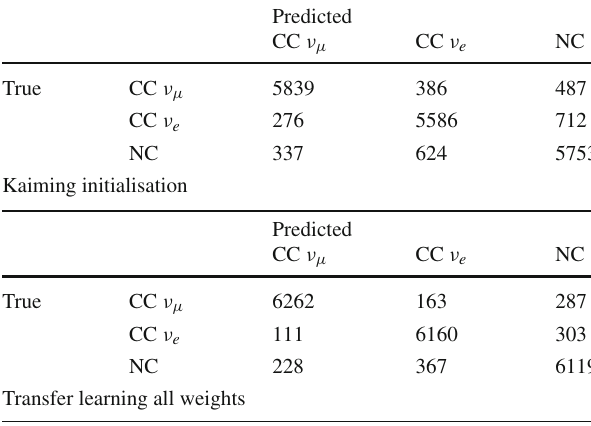
Table 3 Confusion matrices showing the number of correctly and incorrectly classified events for each true class. Results are shown for the network with the highest F1 score in the ensembles with 100,000 trainingimagesforKaiming(top)andtransferlearningallweights(bot- tom) cases